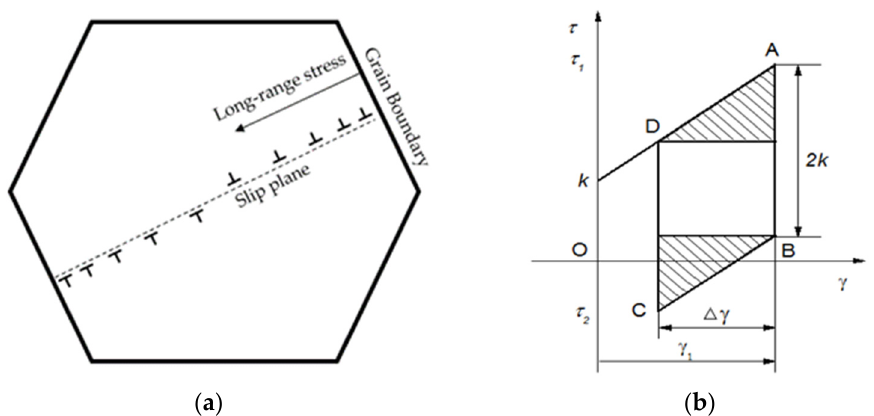
Figure 5. Stored energy model based on dislocation theory in a single crystal: ( a ) dislocation motion in a most favorably oriented grain; ( b ) stored energy in the stress–strain hysteresis loop. The k represents initial yield stress in a single crystal, while the ∆ γ is the strain range.